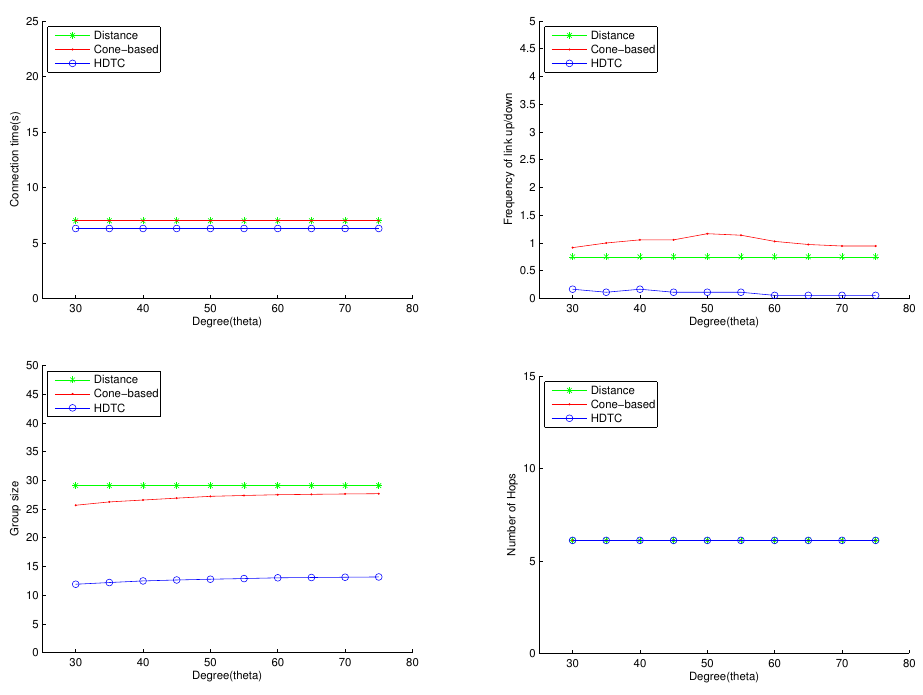
Figure 15. Scenario 2: The connection time, the frequency of the link up/down, the group size and the number of hops with varying θ